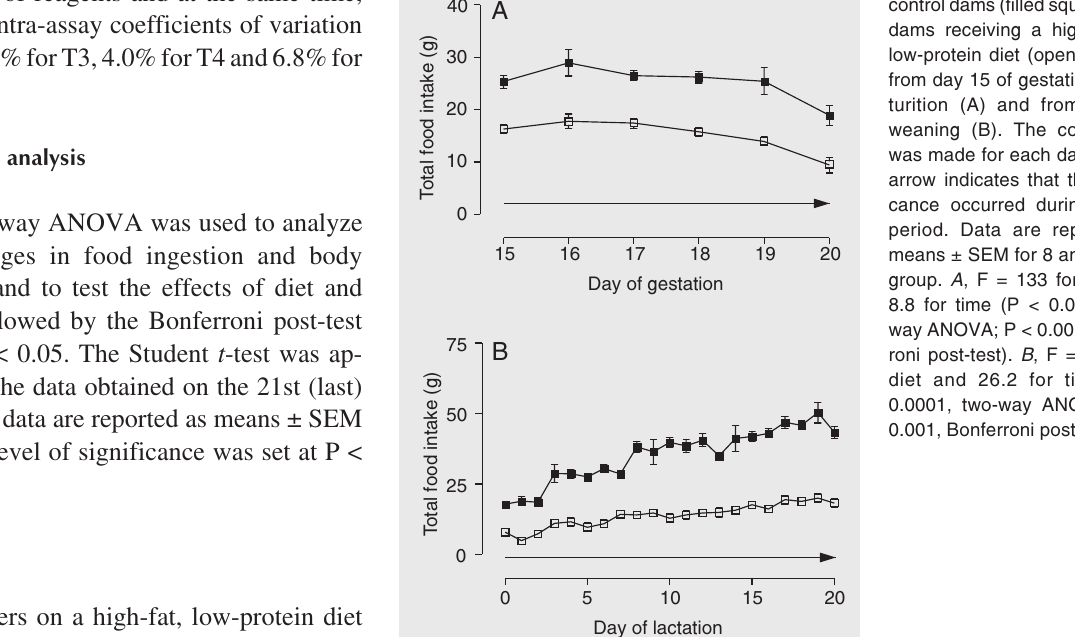
Figure 1. Total food intake by control dams (filled squares) and dams receiving a high-fat and low-protein diet (open squares) from day 15 of gestation to par- turition (A) and from birth to weaning (B). The comparison was made for each day and the arrow indicates that the signifi- cance occurred during all the period. Data are reported as means ± SEM for 8 animals per group. A , F = 133 for diet and 8.8 for time (P < 0.0001, two- way ANOVA; P < 0.001, Bonfer- roni post-test). B , F = 1400 for diet and 26.2 for time (P < 0.0001, two-way ANOVA; P < 0.001, Bonferroni